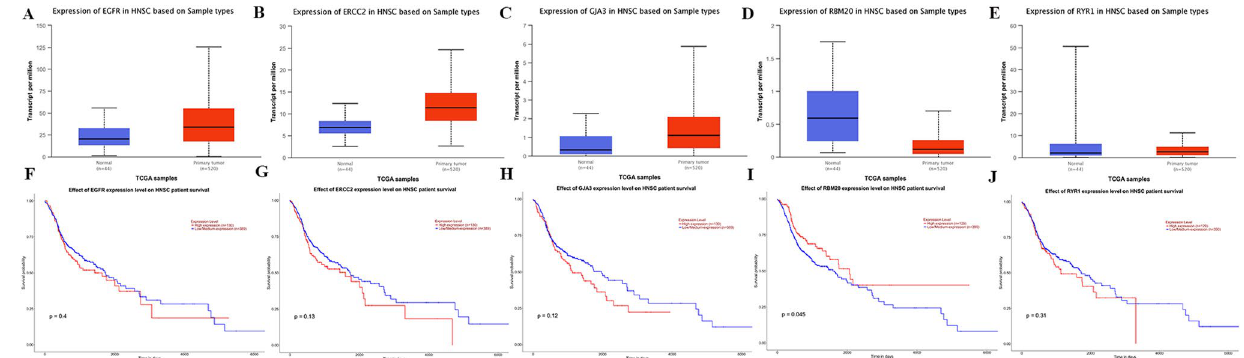
Figure 4. Survival curve and expression of EGFR, ERCC2, GJA3, RBM20 and RYR1 (UALCAN database). ( A–E ) Survival curves. ( F–J ) Expression of genes in liver cancer and normal liver